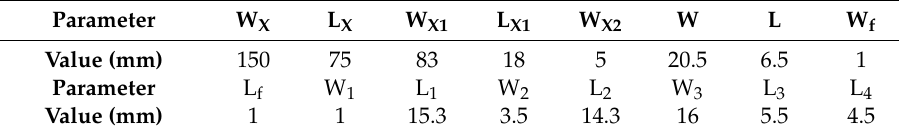
Figure 1. ( a ) Side and ( b ) back views of the multi-mode antenna array. Table 1. The dimension values of the presented multi-mode array.